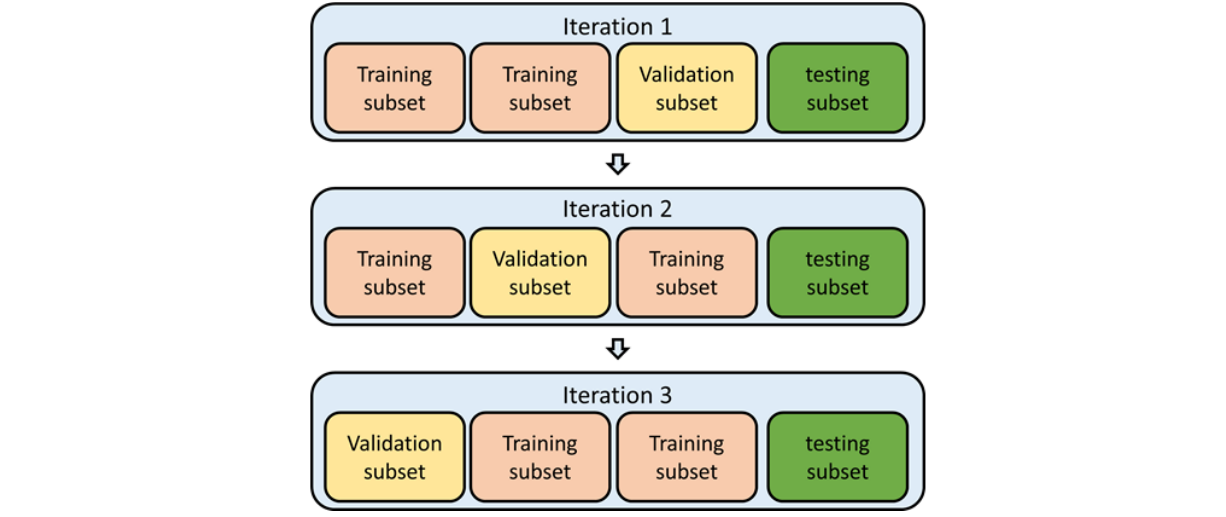
Figure 10. Workflow of 3-fold